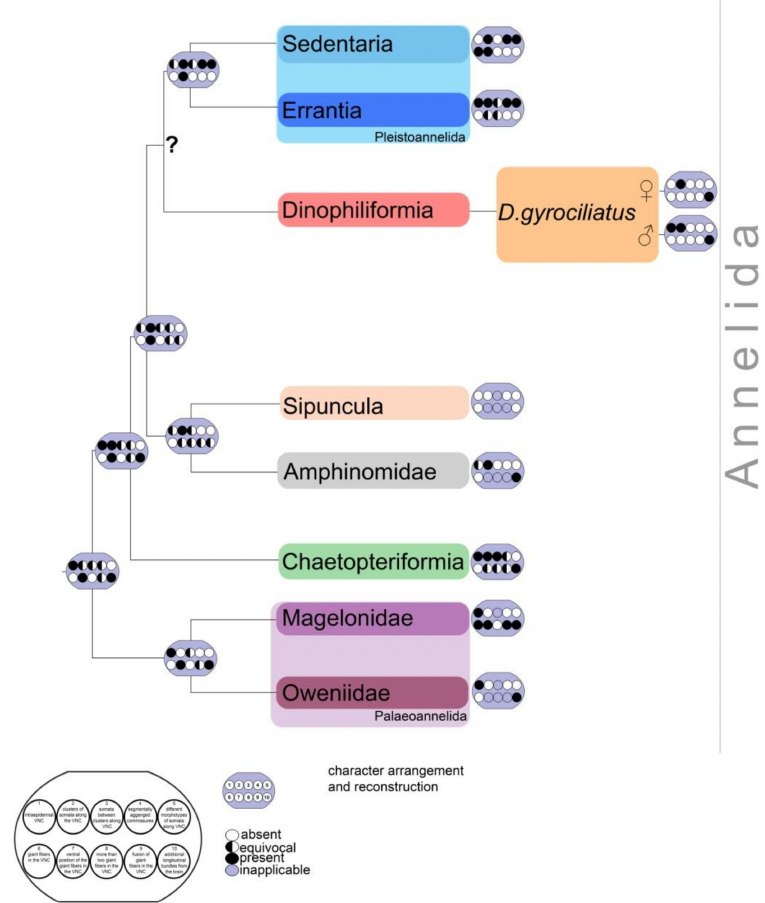
Figure 14. Schematic diagram of the ventral nervous system anatomy across Annelida phylogenetic tree with addition of Dimorphilus gyrociliatus data. Phylogenetic tree is based on [1,2] the characters pattern and distribution is based on [16]. The legend and character arrangement and reconstruction matrixes were adapted from [16]. The characters are coded in a way: absent (white), present (black) and inapplicable (grey). Note the difference between D. gyrociliatus male and female